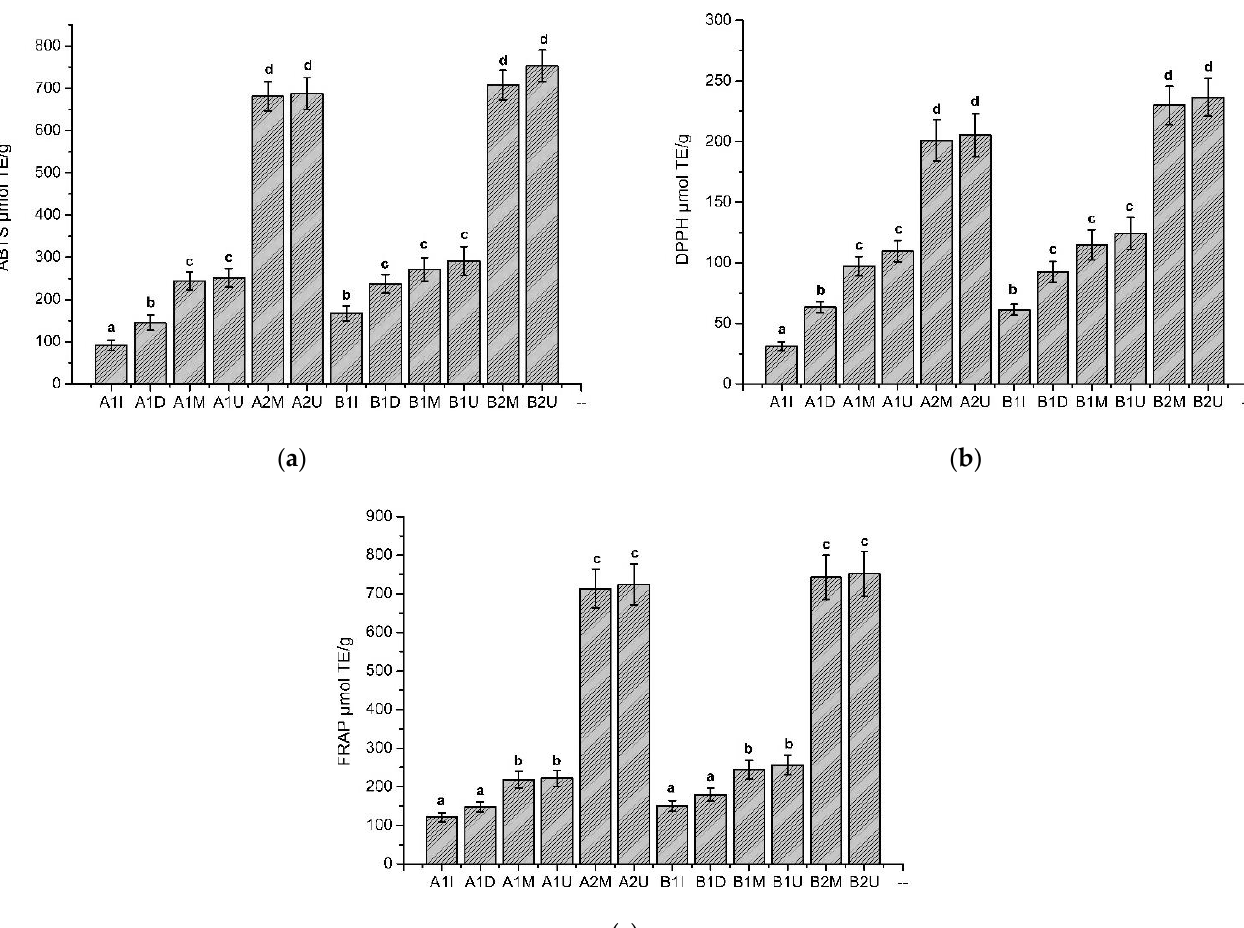
Figure 2. The antioxidant activity of balsam poplar bud extracts samples in vitro by ( a ) ABTS, ( b ) DPPH, ( c ) FRAP methods (fresh and dried balsam poplar buds were used for extraction). The extracts made from fresh plant material are marked with the letter A, the extracts made from dried plant material are marked with the letter B. The extracts prepared by different methods are marked accordingly: I-infusions, D-decoctions, M-maceration, U-ultrasound. Different solvents were used for the extraction, which are denoted respectively: 1-purified water, 2-70% ethanol ( v/v )). The results are expressed as µmol of the trolox equivalent per g (µmol TE/g). The different letters in superscript (a – d) indicate a statistical difference between the an tioxidant activity of the extracts by a Student’s t -test ( p < 0.05).